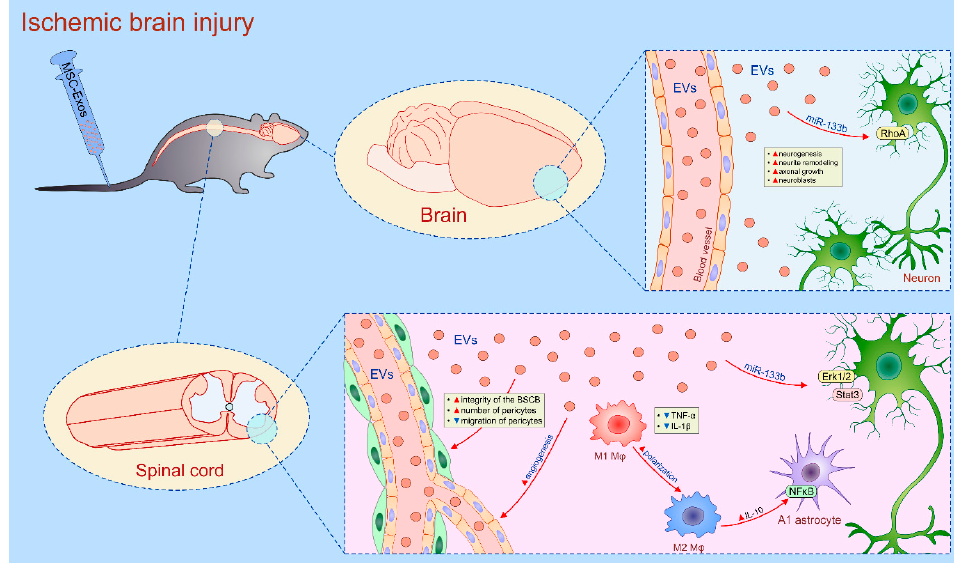
Figure 6. Molecular mechanisms responsible for beneficial effects of MSC-derived secretomes in the therapy of ischemic brain damage and spinal cord injury. Administration of MSC-sourced extracellular vesicles (EVs), including MSC-derived exosomes (Exos), promoted neural regeneration in animal models of ischemic brain damage and spinal cord injury (SCI). MSC-Exos-based therapy improved neurogenesis, promoted axonal growth, increased presence of neuroblasts and endothelial cells (ECs) in ischemic regions of the brain. MSCs-Exo regulated neurogenesis by supplying neurons with miR-133b which promoted neurite outgrowth by targeting Ras homolog gene family member A (RhoA). Similarly, systemic injection of miR-133b-bearing MSC-Exos promoted recovery from SCI by promoting regeneration of axons through the activation of survival Erk1/2 and Stat-3 signaling pathways in regenerating neurons. After intravenous administration, MSC-Exos accumulated at the site of SCI and promoted generation of immunosuppressive M2 macrophages which, in IL-10-dependent manner, suppressed activation of neurotoxic A1 astrocytes through the inhibition of NF-kB. In similar manner, via down-regulation of NF- κ B p65 signaling, MSC-EVs reduced migratory capacities of pericytes and maintained structural integrity of blood- spinal cord barrier (BSCB). In addition to their direct neuroprotective effects of injured neurons, MSC-Exos are also able to modulate microenvironment of spinal cord lesions through their anti-inflammatory and pro- angiogenic effects [135,136]. As evidenced by Huang and colleagues, systemic application of MSC- Exos promoted functional recovery following SCI by inducing neo-angiogenesis and through the suppression of TNF- α and IL-1 β -driven inflammation [135]. Furthermore, MSC-Exo treatment enhanced production of immunosuppressive IL-10 which suppressed neurotoxic A1 astrocytes [135]. In line with these findings, Wang and co-workers showed that MSC-Exos may prevent pro- inflammatory properties of A1 astrocytes by inhibiting nuclear translocation of p65 subunit of NF- κ B, which is crucially important for the generation of inflammatory phenotype in these cells [137]. In addition to N1 astrocytes, macrophages were the main cellular targets in MSC-Exo-based immunomodulation of SCI [136,138]. After intravenous administration, MSC-Exos accumulated at the site of SCI where promoted polarization of inflammatory M1 macrophages into immunosuppressive M2 phenotype. Accordingly, enhanced presence of CD206-expressing and IL- 10-producing M2 macrophages and reduced number of TNF- α and IL-1 β -producing M1 macrophages were observed in spinal cord lesions of MSC-Exo-treated animals [136,138]. Having in mind that TNF- α and IL-1 β -driven inflammation results in severe neuropathic pain, Shiue and colleagues investigated therapeutic potential of MSC-Exos in attenuation of nerve-injury induced pain [139]. They demonstrated that continuous intrathecal infusion of human UCD-MSC-Exos